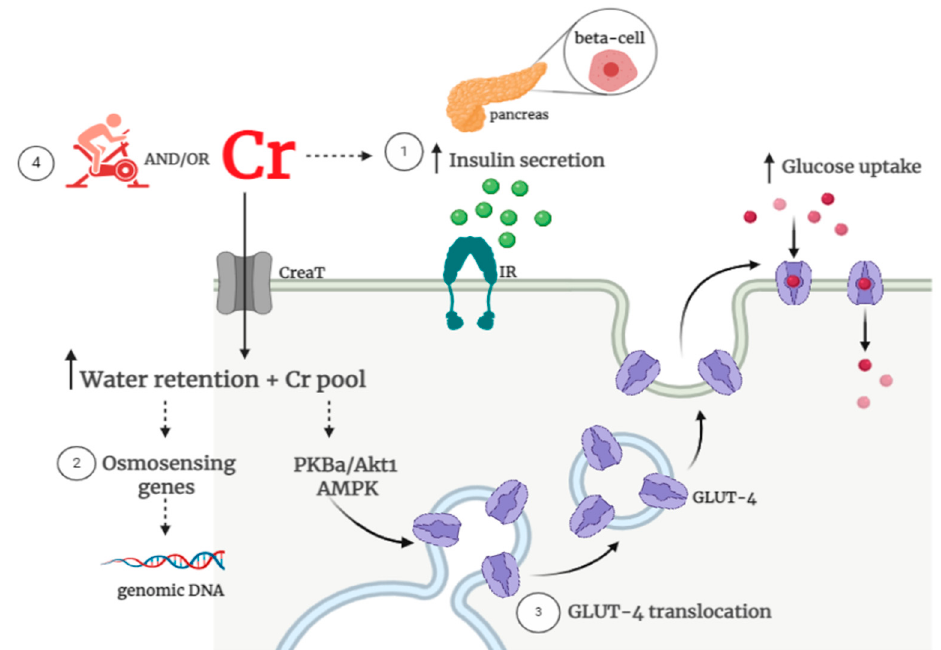
Figure 1. Possible creatine-related mechanisms on glycemic control. Potential mechanisms underpinning the role of creatine on glucose metabolism involve: (1) increased beta-cell insulin secretion; (2) improved water retention and osmosens-